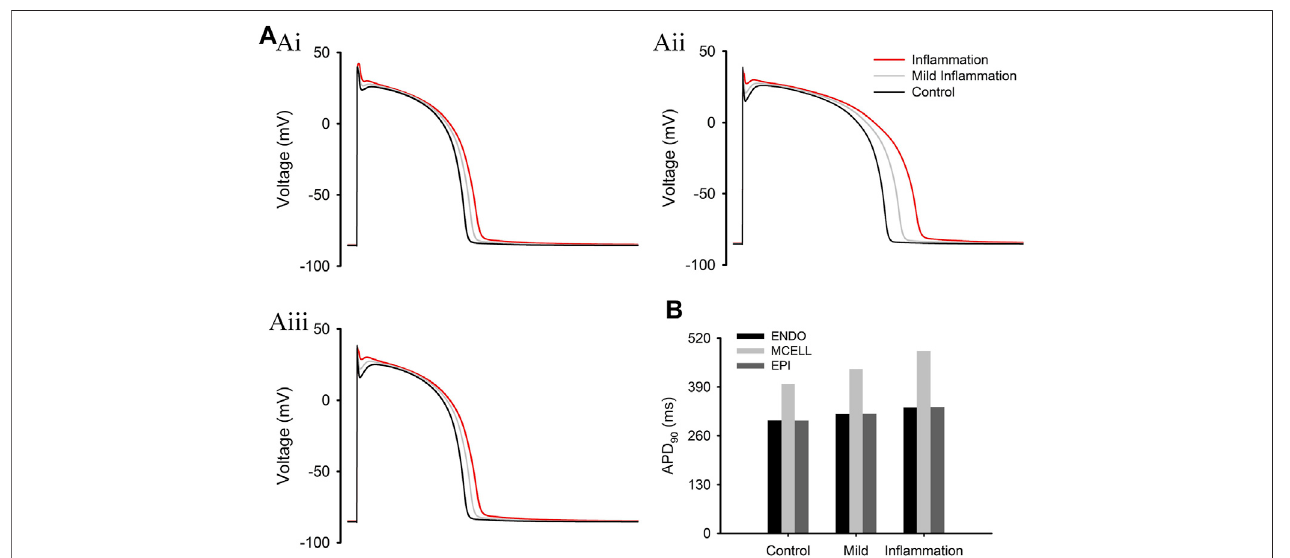
FIGURE3| Simulationresultsunderdifferentlevelsofin fl ammation. (A) APsofENDO (Ai) ,MID (Aii) ,andEPI (Aiii) cellsatdifferentlevelsofin fl ammation. (B) APD 90 of three types of cells under normal and in fl ammatory conditions.